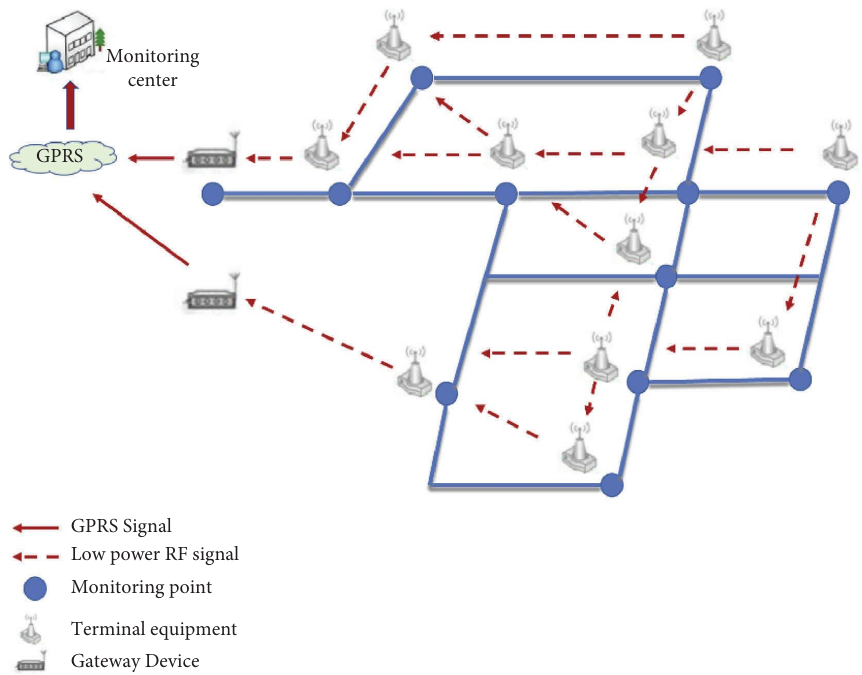
Figure 1: Schematic diagram of system architecture and